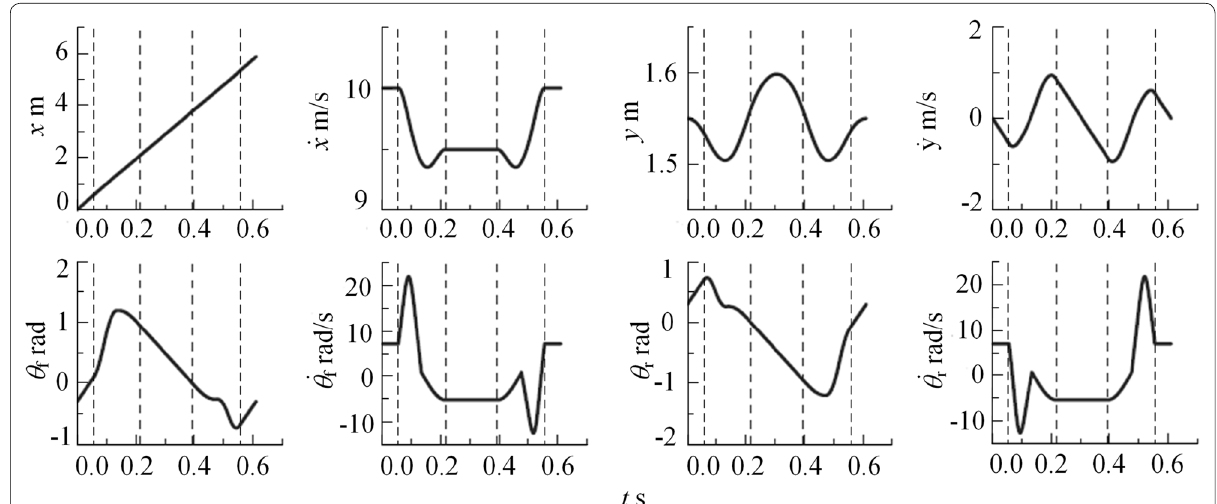
Figure 3 Trajectories of each state variable in one cycle